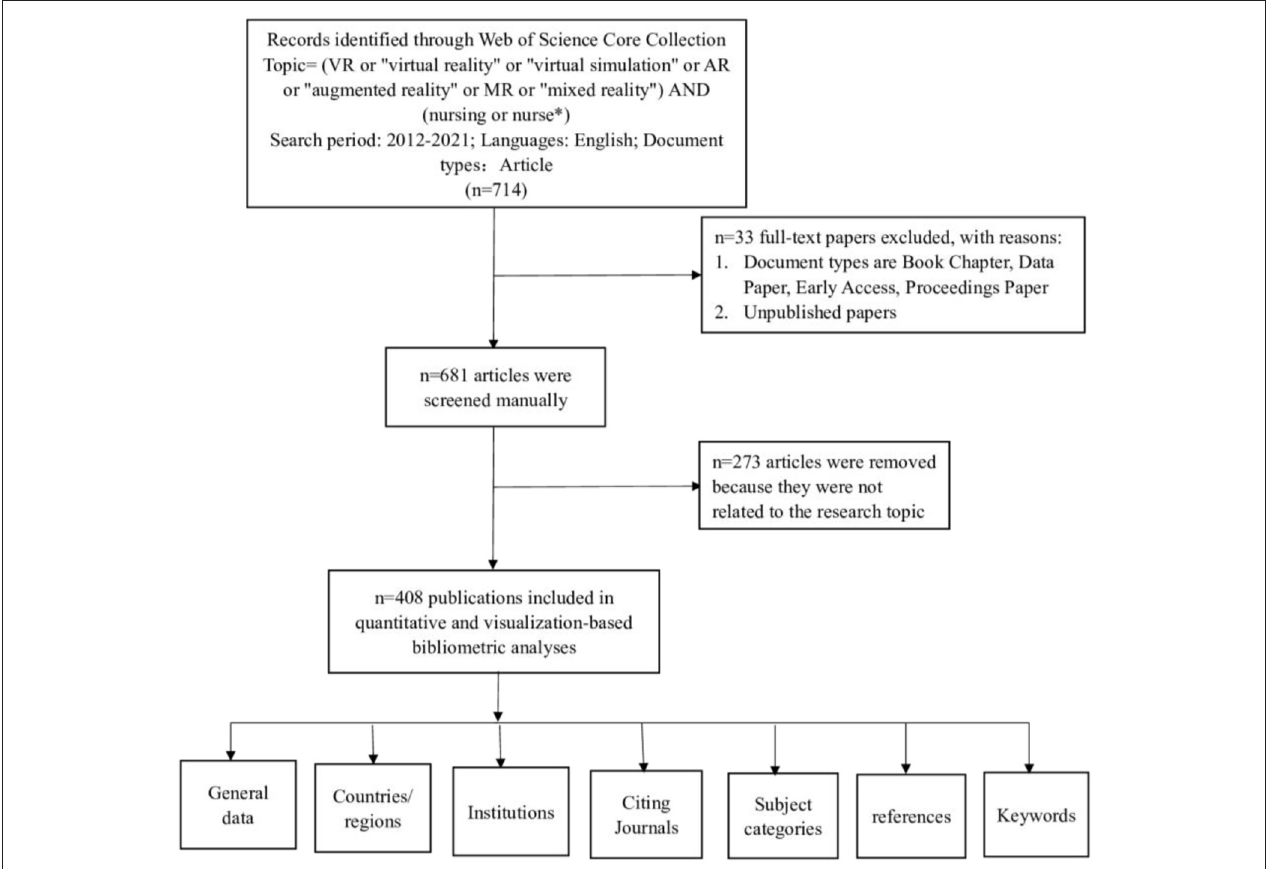
FIGURE 1 | A frame flow diagram showing the detailed selection criteria and bibliometric analysis steps of applying VR to the study of nursing. Basic data of 408 literatures were included in the analysis.